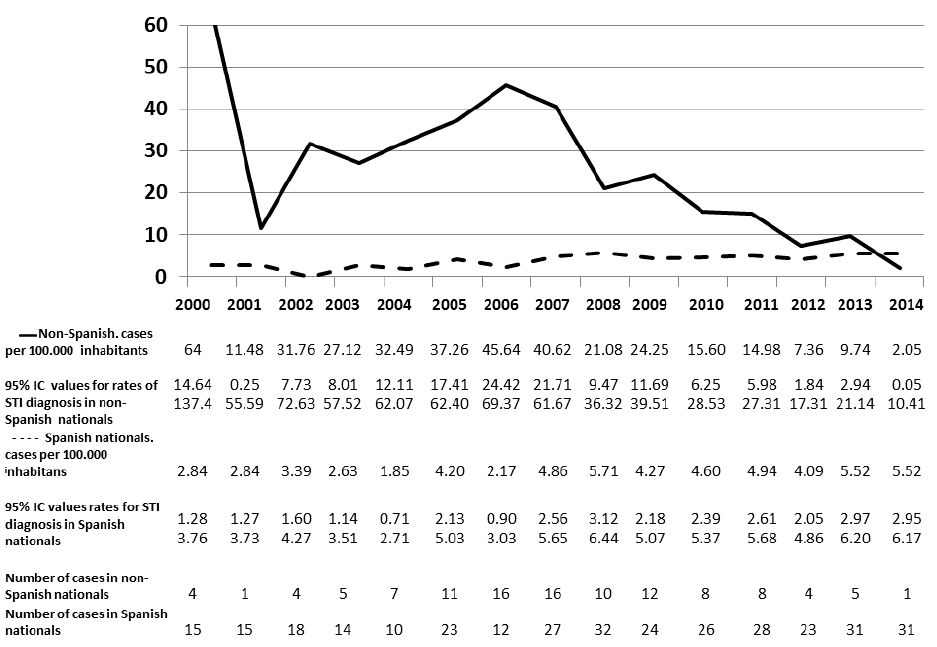
Table 3. Annual odds ratios for STIs in non-native populations versus native populations aged between 15 and 64 years old. Granada, Spain, 2000–2014.